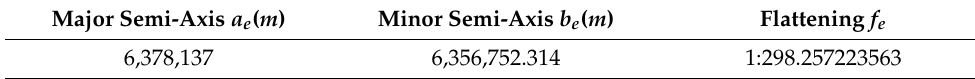
by four vertices (upper left, upper right, lower right, lower left). The relative